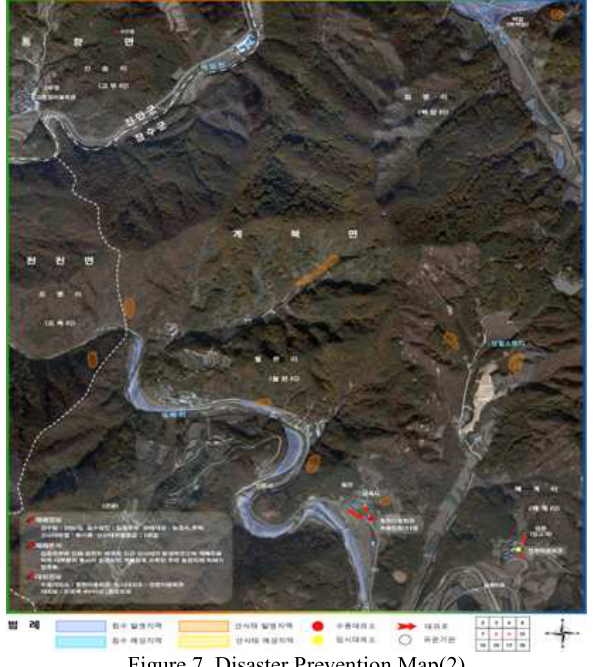
Figure 7. Disaster Prevention